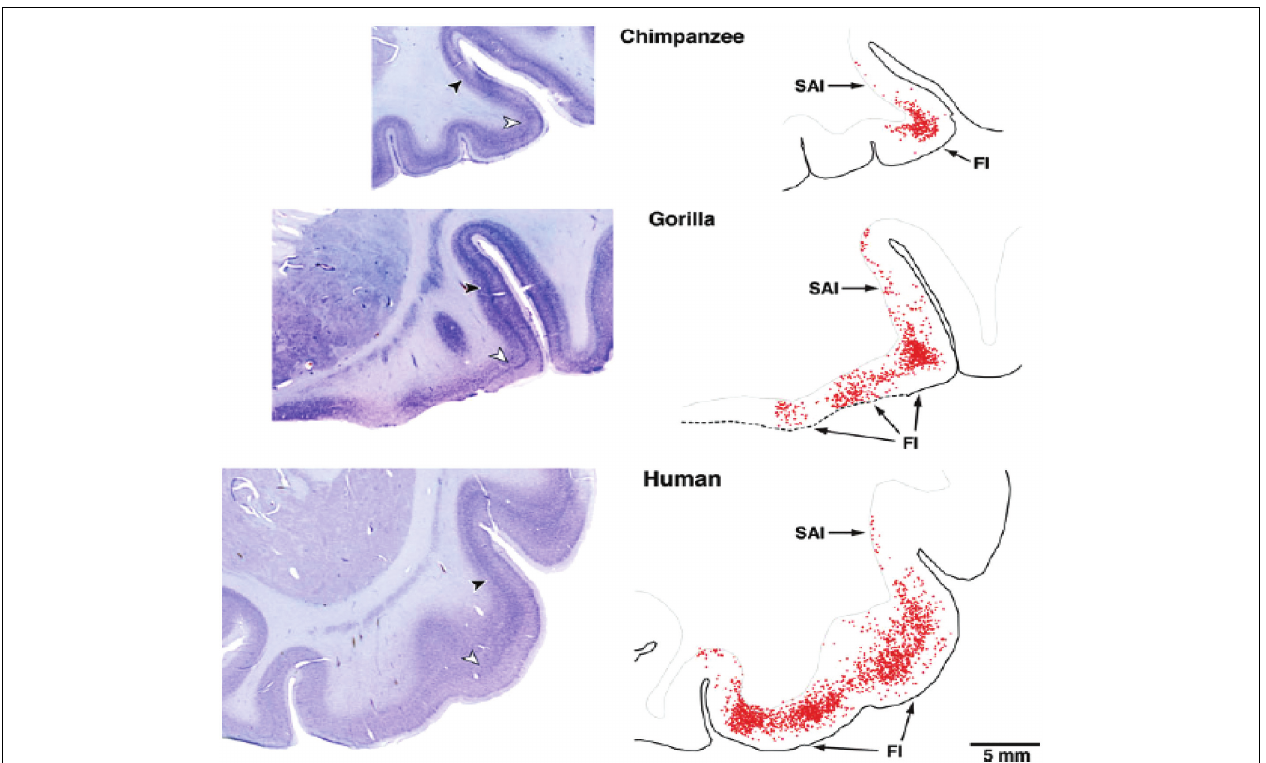
FIGURE 4 | von Economo neurons are present in LayerV of primate insula cortex (Allman etal., 2010).